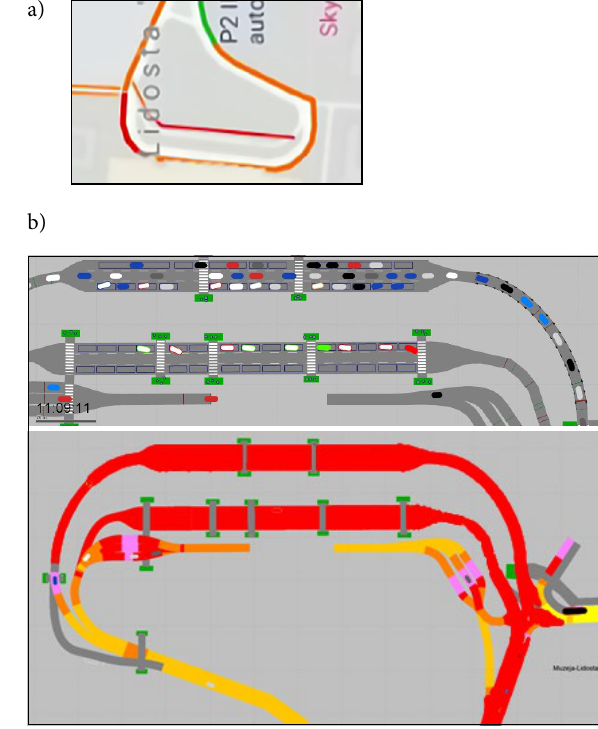
Figure 7. Example of traffic data near departure terminal: a – traffic flow intensity; b – traffic flow structure